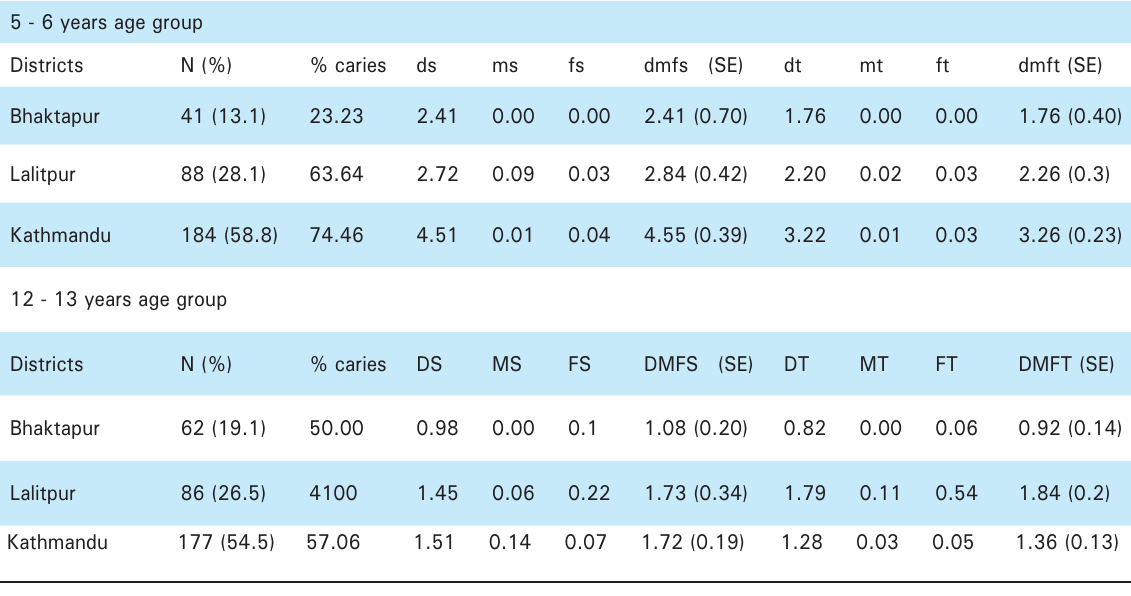
Table 4. Dental caries status in the 5 - 6 years and 12 -13 years age group by